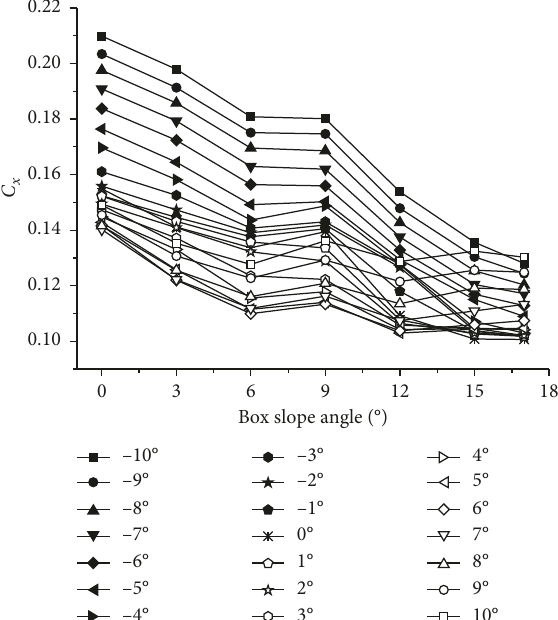
Figure 11: C x vs. box slope angle for various